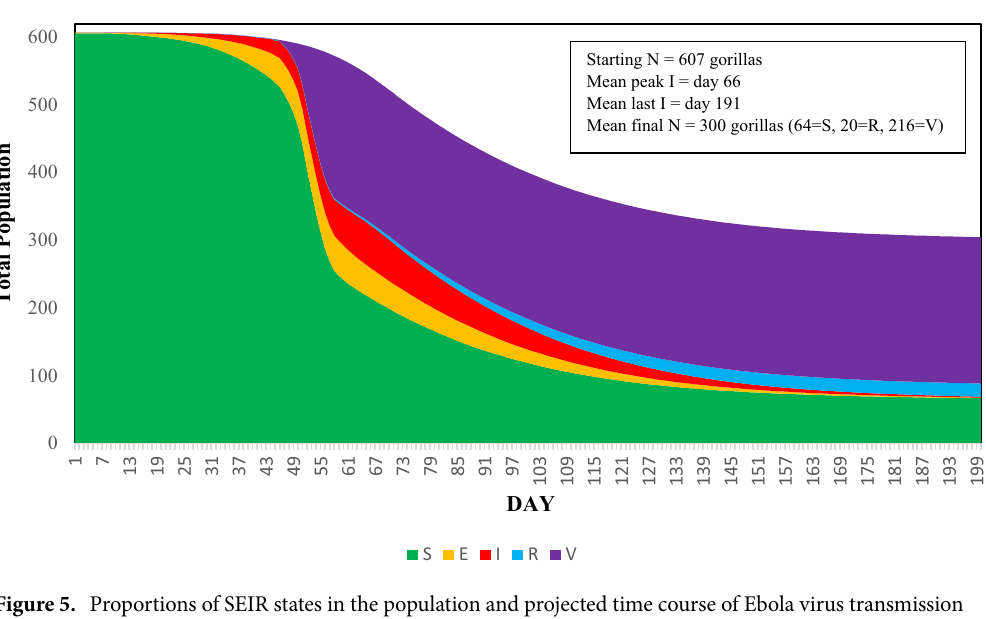
Figure 5. Proportions of SEIR states in the population and projected time course of Ebola virus transmission after entering the mountain gorilla population with one infected individual in the DRC-1 group at Day 0, when vaccinations are administered to 50% of the habituated gorillas 6 weeks after the first gorilla becomes infectious. S—Susceptible, never infected; E—Exposed and infected; I—Infectious; R—Recovered; V—effectively Vaccinated. Lines averaged across 500